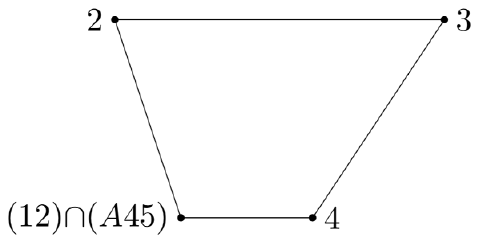
Figure 12 . The region bounded by lines (12) ; (23) ; (34) and (45) whose canonical form is given by